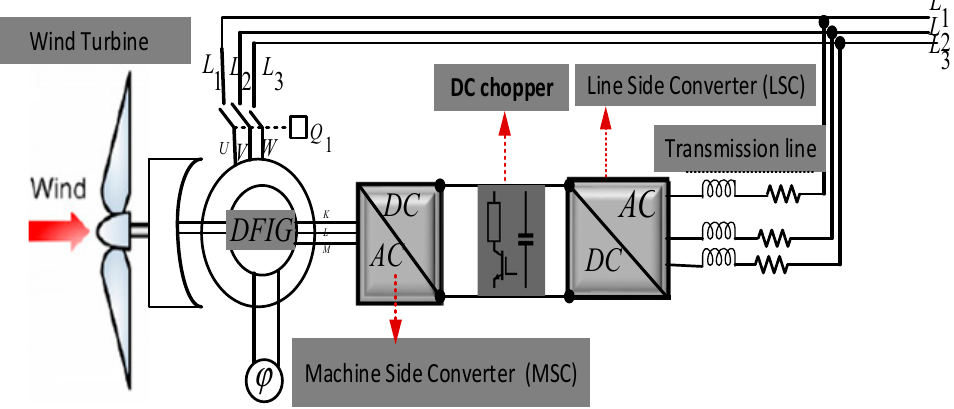
Figure 7. General diagram of a wind turbine with a DFIG.